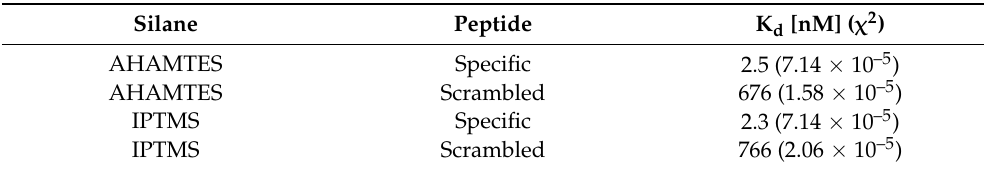
Figure 2. SPR binding curves of MIPs prepared using AHAMTES and IPTMS against specific and scrambled peptides. Table 2. Dissociation constants (K d ) of MIPs prepared using AHAMTES and IPTMS-functionalised glass against specific and scrambled peptide.